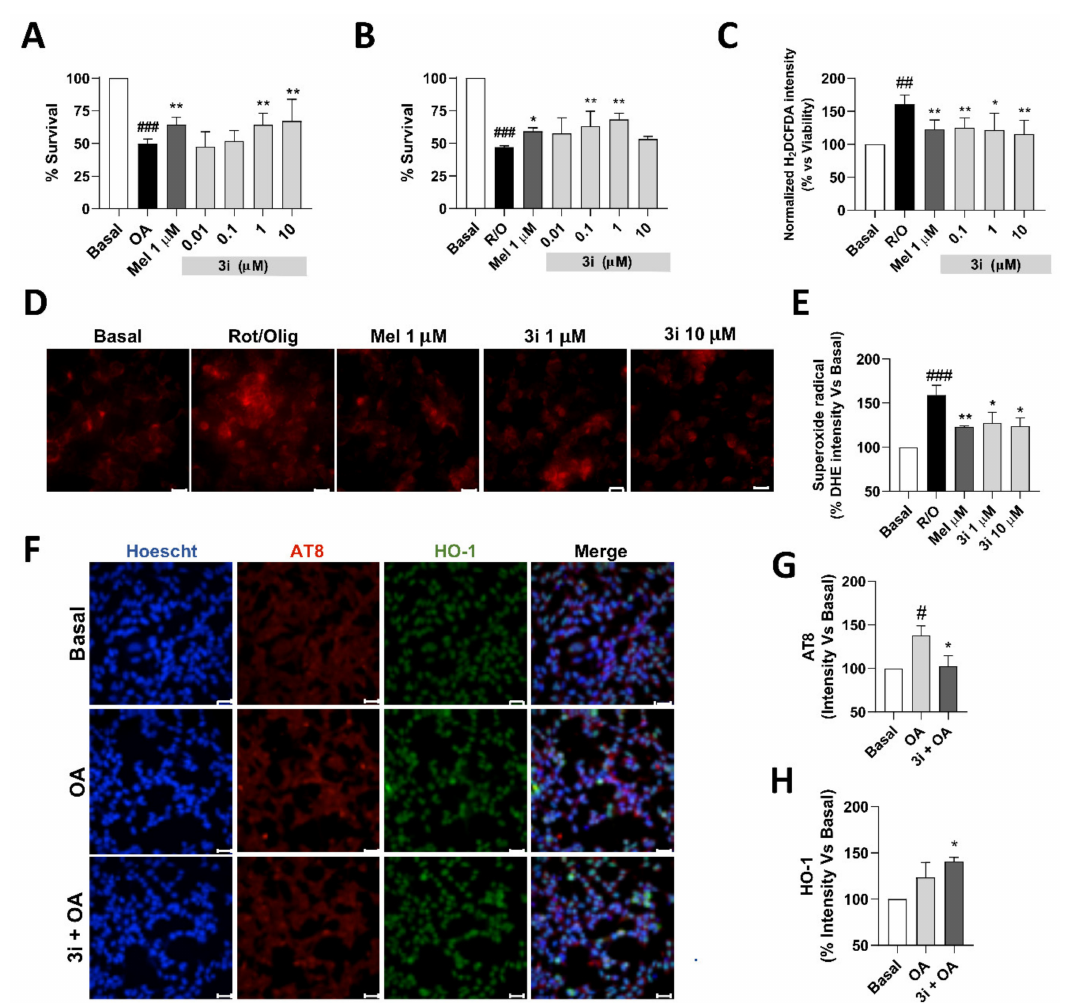
Figure 7. Neuroprotection capacity and mechanism of action of compound 3i . ( A ) Survival (%) of SH-SY5Y cells following toxicity elicited by okadaic acid (20 nM) in the presence of increasing concentrations of 3i . ( B ) Survival (%) of SH-SY5Y cells following toxicity elicited by okadaic acid (20 nM) in the presence of increasing concentrations of 3i . ( C ) Total free radical production induced by toxic R/O combination for 6 h, measured as H 2 DCFDA fluorescence increase compared to basal conditions (DMSO). ( D ) Superoxide production induced by toxic R/O combination for 6 h, measured as DHE fluorescence increase, representative microphotographs (scale bar: 25 µ M). ( E ) Quantification of DHE fluorescence increase compared to basal conditions. ( F ) Representative microphotographs (scale bar: 25 µ M) of SH-SY5Y cells treated with 3i (10 µ M) during 24 h and then co-incubated with compound 3i and OA (20 nM). Finally, cells were stained with Nuclei (Hoechst, Blue), phospho-tau (AT8, Red), and HO-1 (anti-HO-1, Green) and merge images. ( G ) Immunofluorescence quantification of phospho-tau production normalized to basal conditions considered as 100%. ( H ) Immunofluorescence quantification of HO-1 expression normalized to basal conditions considered as 100%. Data are expressed as mean ± SEM of 3 experiments in duplicate. One-way ANOVA Newman–Keuls post-test # p < 0.05; ## p < 0.01; ### p < 0.001; compared to basal. * p < 0.05, ** p < 0.01; compared to toxic